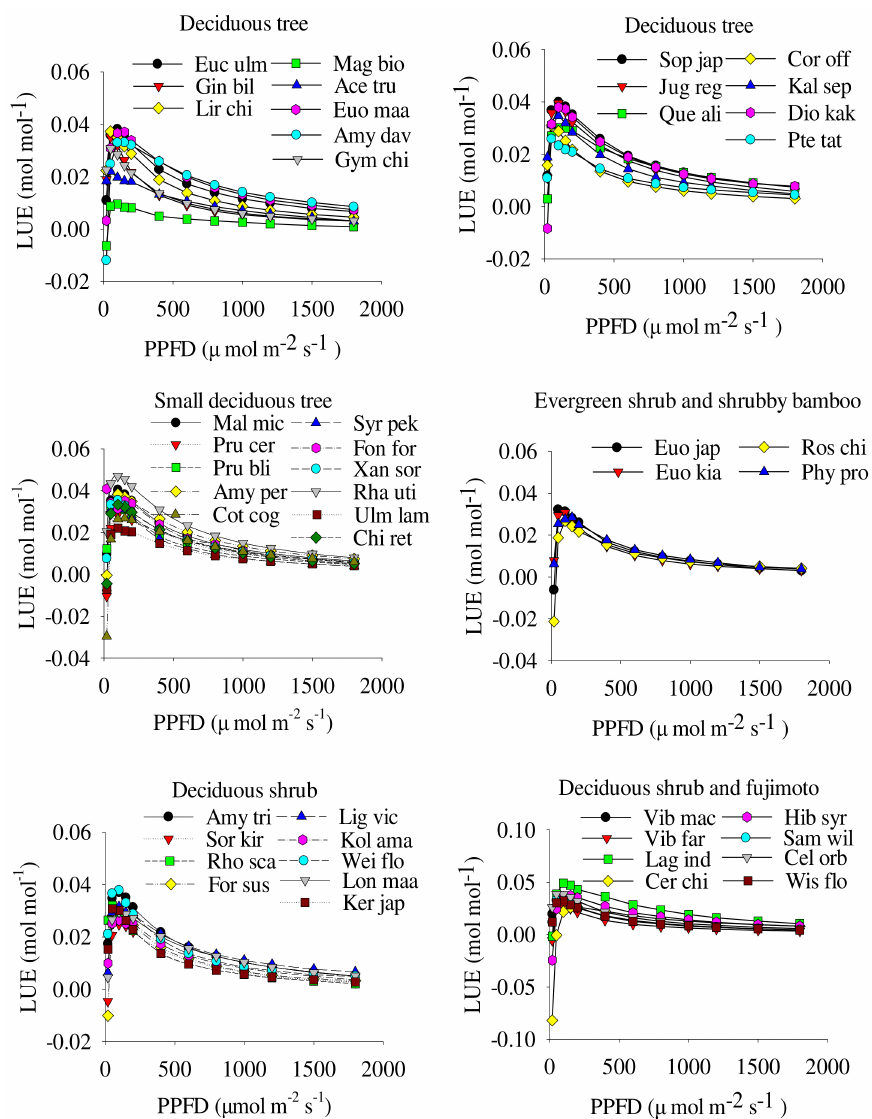
Figure 3. Light-energy-utilization efficiency curves (mean ± SE, n = 5) of forty-seven species. LUE and PPFD are light-utilization efficiency and photosynthetic photon flux density, respectively. Species abbreviations are shown in Table